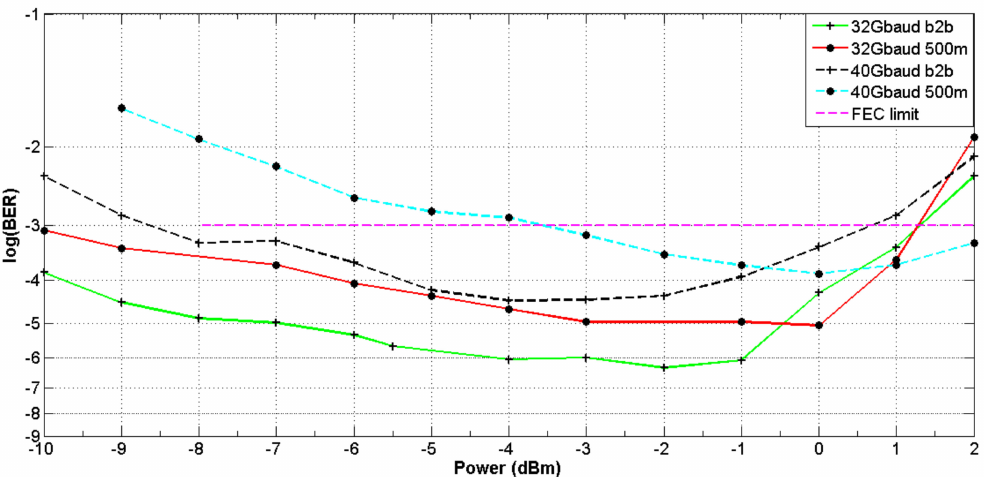
Figure 7. Bit error rate (BER) curves at 32 and 40 Gbaud in back-to-back configuration and after propagation over 500 m.